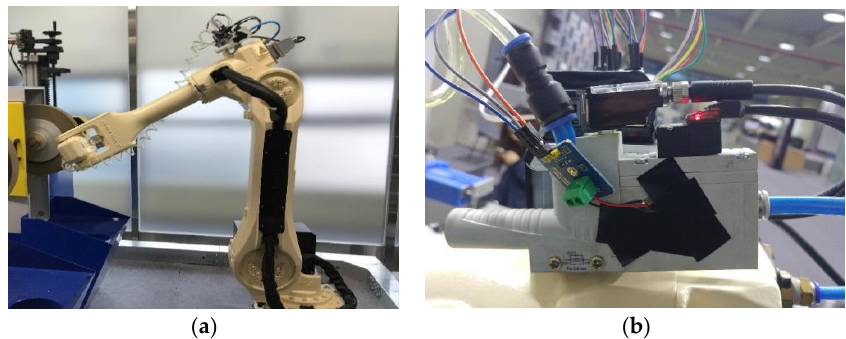
Figure 2. Target facility for fault detection: ( a ) grinding robot manipulator; ( b ) vacuum ejector